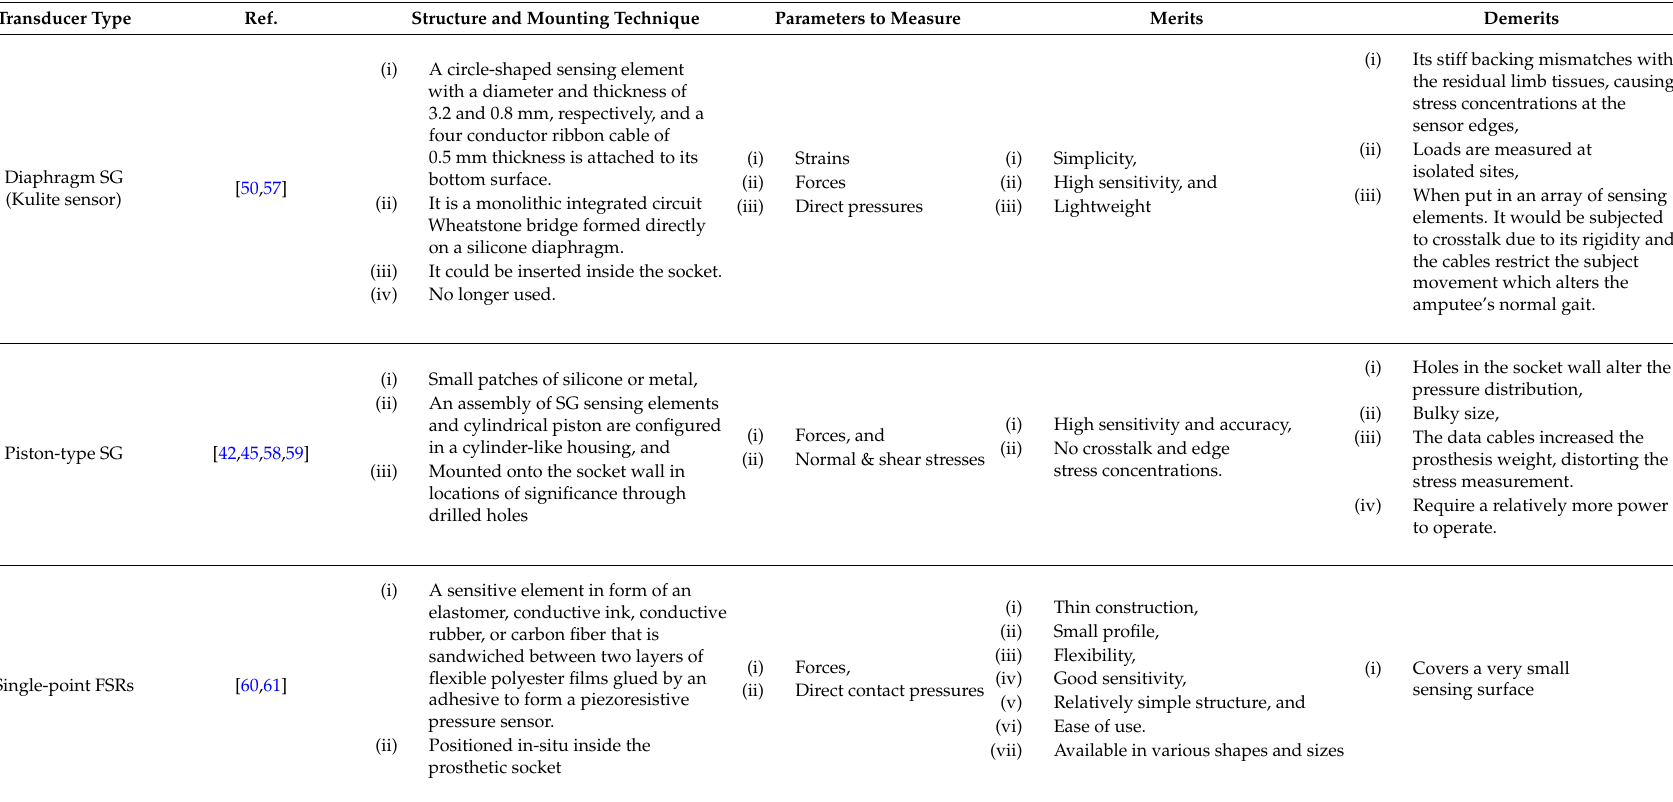
Table 1. Types of transducers used in transtibial prosthetic sockets and their relative merits and demerits. Transducer